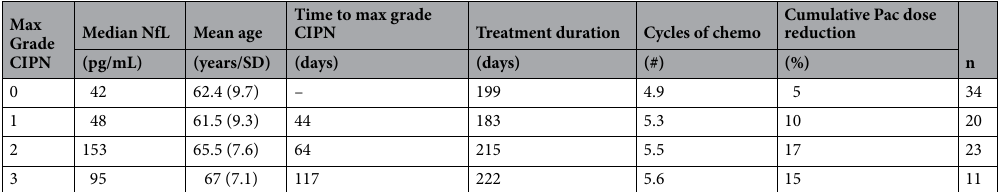
Table 2. Subject details summarized by highest grade of CIPN reported. Values reflect median NfL change, average age in years (SD), average of time to report of highest grade CIPN, time on study, reduction in cumulative dose of paclitaxel. Chemo: Chemotherapy; Pac: